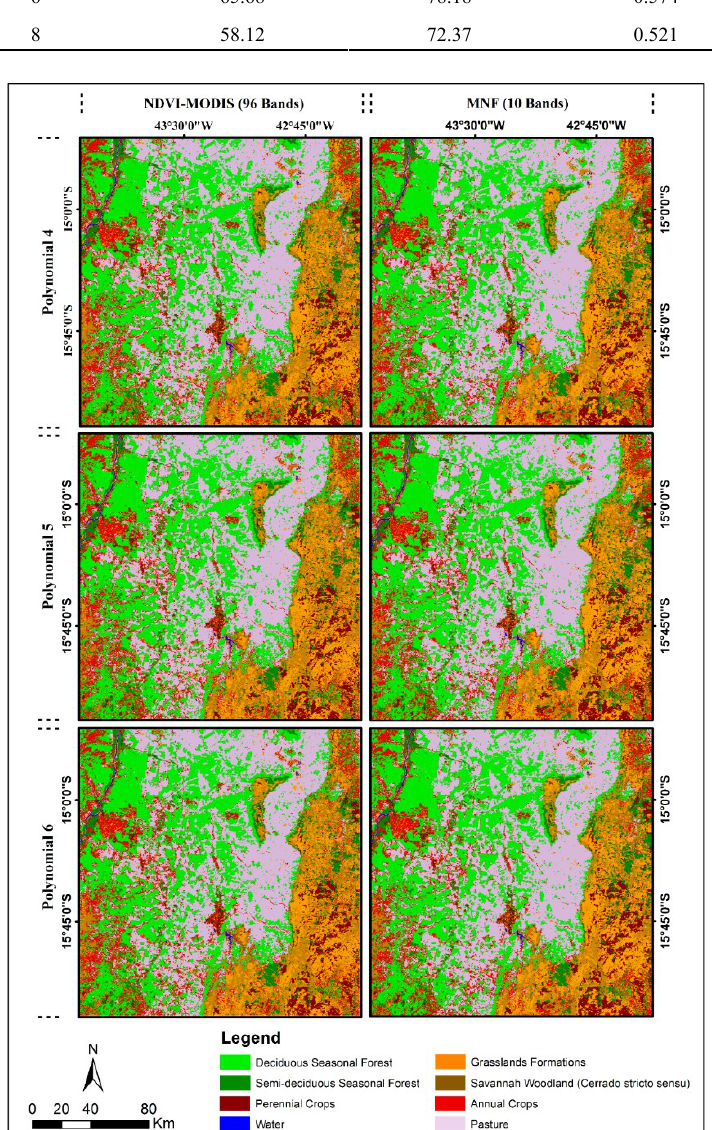
Figure 10. SVM classification maps considering two types of input data (NDVI-MODIS time series and MNF signal components) and three types of polynomial kernel functions (fourth, fifth, and sixth